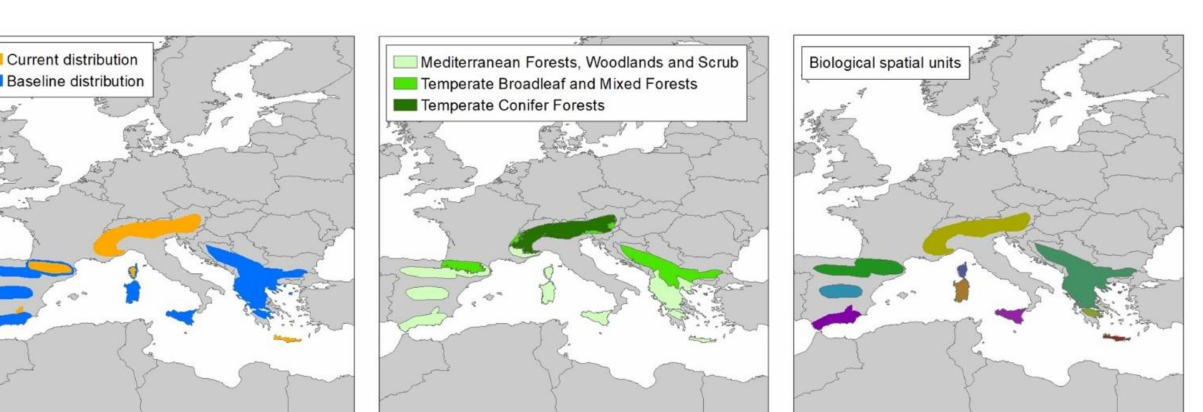
Figure 5. Change in Green Score as a function of change in number of spatial units when comparing country-based spatial units (SUs) to biologically based SUs (country-based results minus biologically based results; C-B). Each point represents a species ( n = 29). Dashed lines intersect at the origin. Note the different x-axes. ( Left ): Comparison of results between fine-scale country-based spatial units (all countries within baseline distribution) and biologically based spatial units. ( Center ): Coarse- scale country-based spatial units (countries comprising ≥ 1% of baseline distribution) compared to biologically based spatial units. ( Right ): Coarse-scale country-based spatial units (countries comprising ≥ 5% of baseline distribution) compared to biologically based spatial units. Negative values on either axis indicate lower values were generated using ecologically based SUs compared to biologically based SUs.